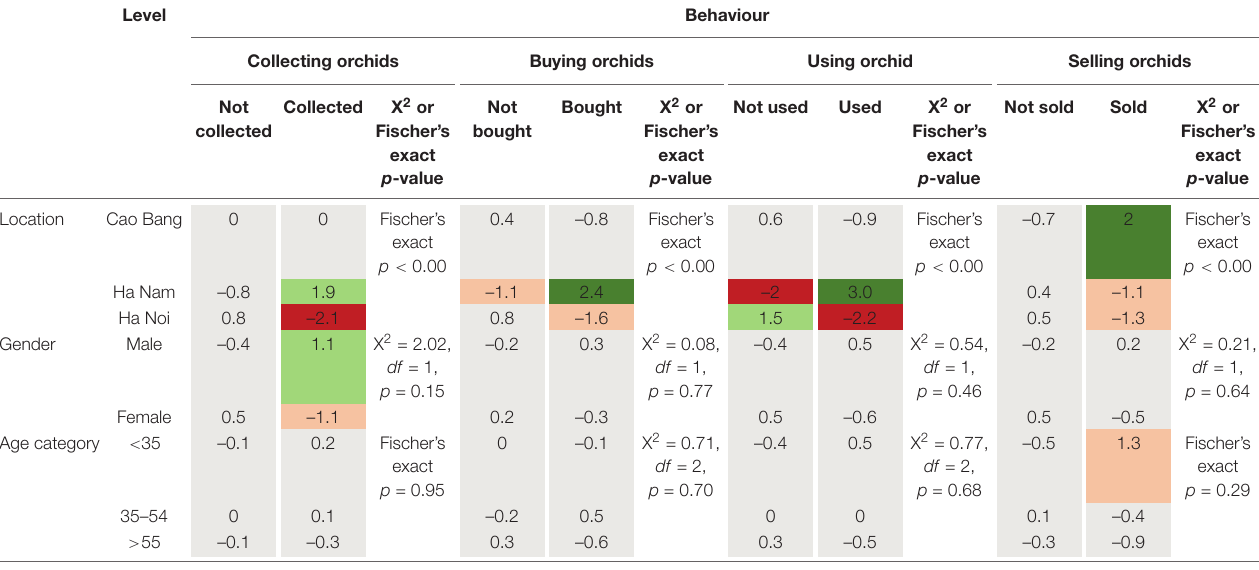
TABLE 2 | The relationship between reporting one of four orchid-related behaviours (collecting, buying, using, or trading) and province, gender and age, determined using X 2 or Fischer’s exact tests with standardised residual values.